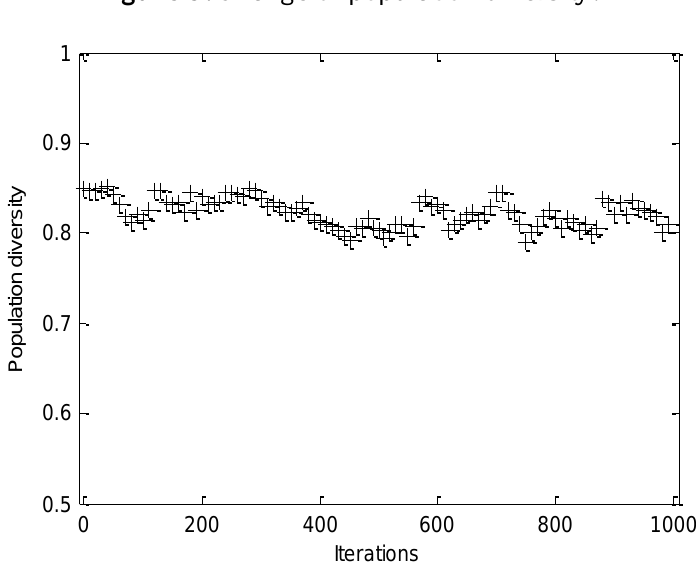
Figure 5. Change of population diversity.